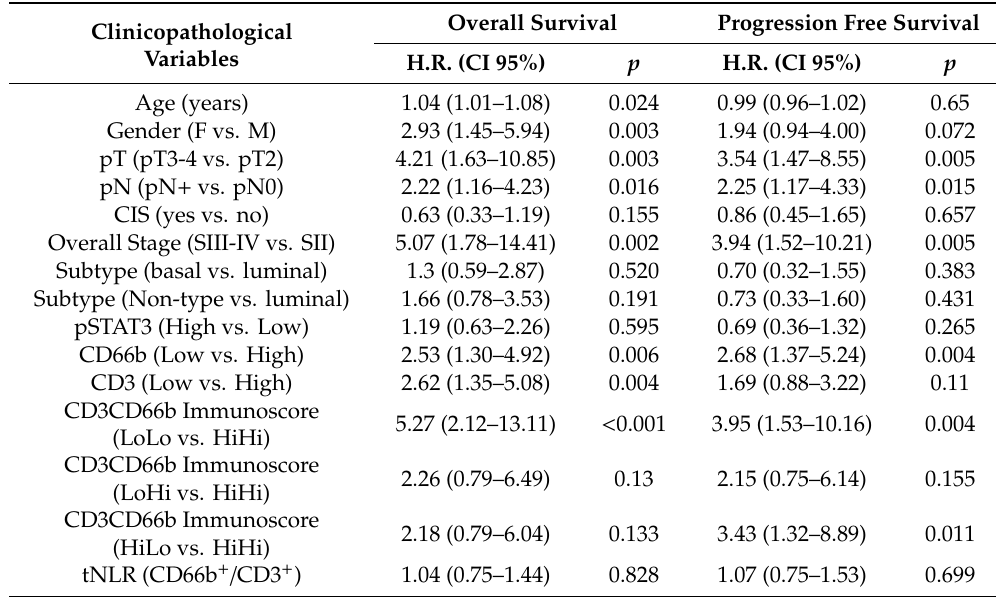
Table 2. Univariate analysis of clinical and pathological findings related to overall survival and progression free survival. tNLR, tissue